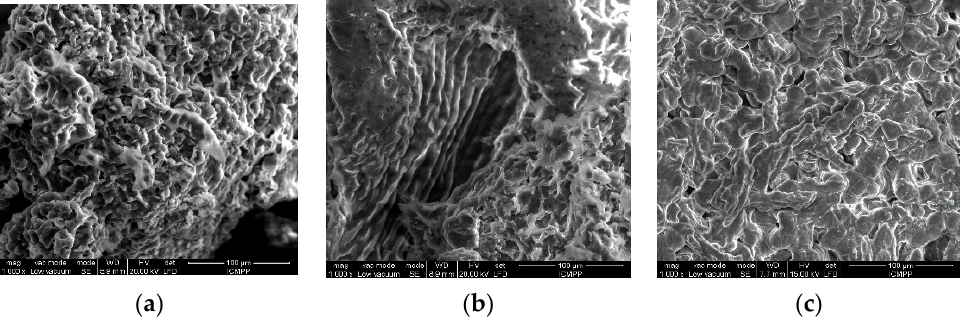
Figure 1. SEM images of mustard biochar (MBC) ( a ), soy biochar (SBC) ( b ), and algae biochar (ABC) ( c ).